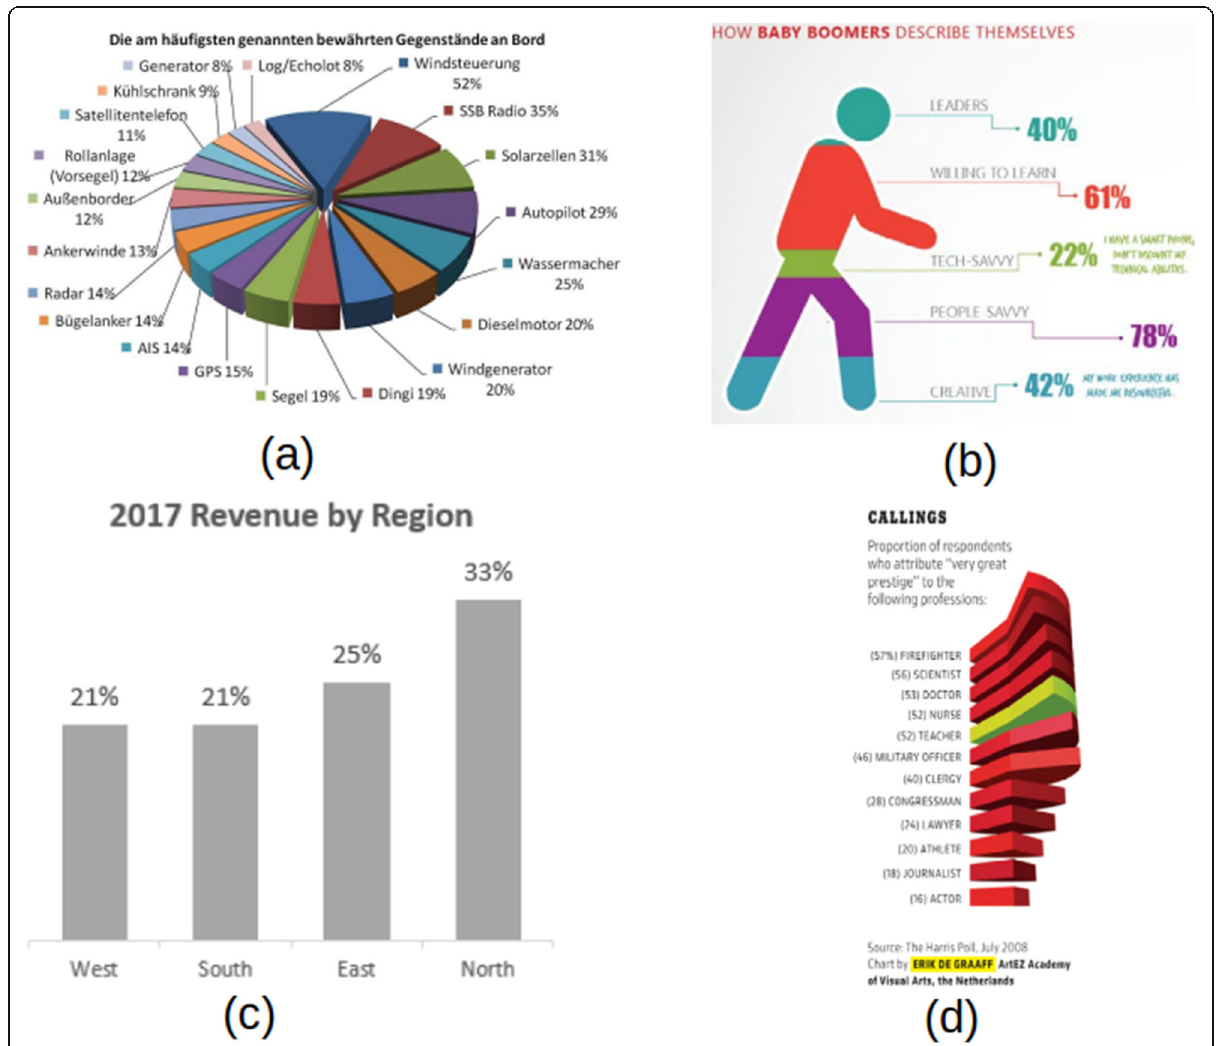
Fig. 7 Misinformation due to shape violation: a using 3D pie chart for comparing proportion [40], b using wrong visualization chart type, c pie- chart should be used [41], and d bar chart should be used